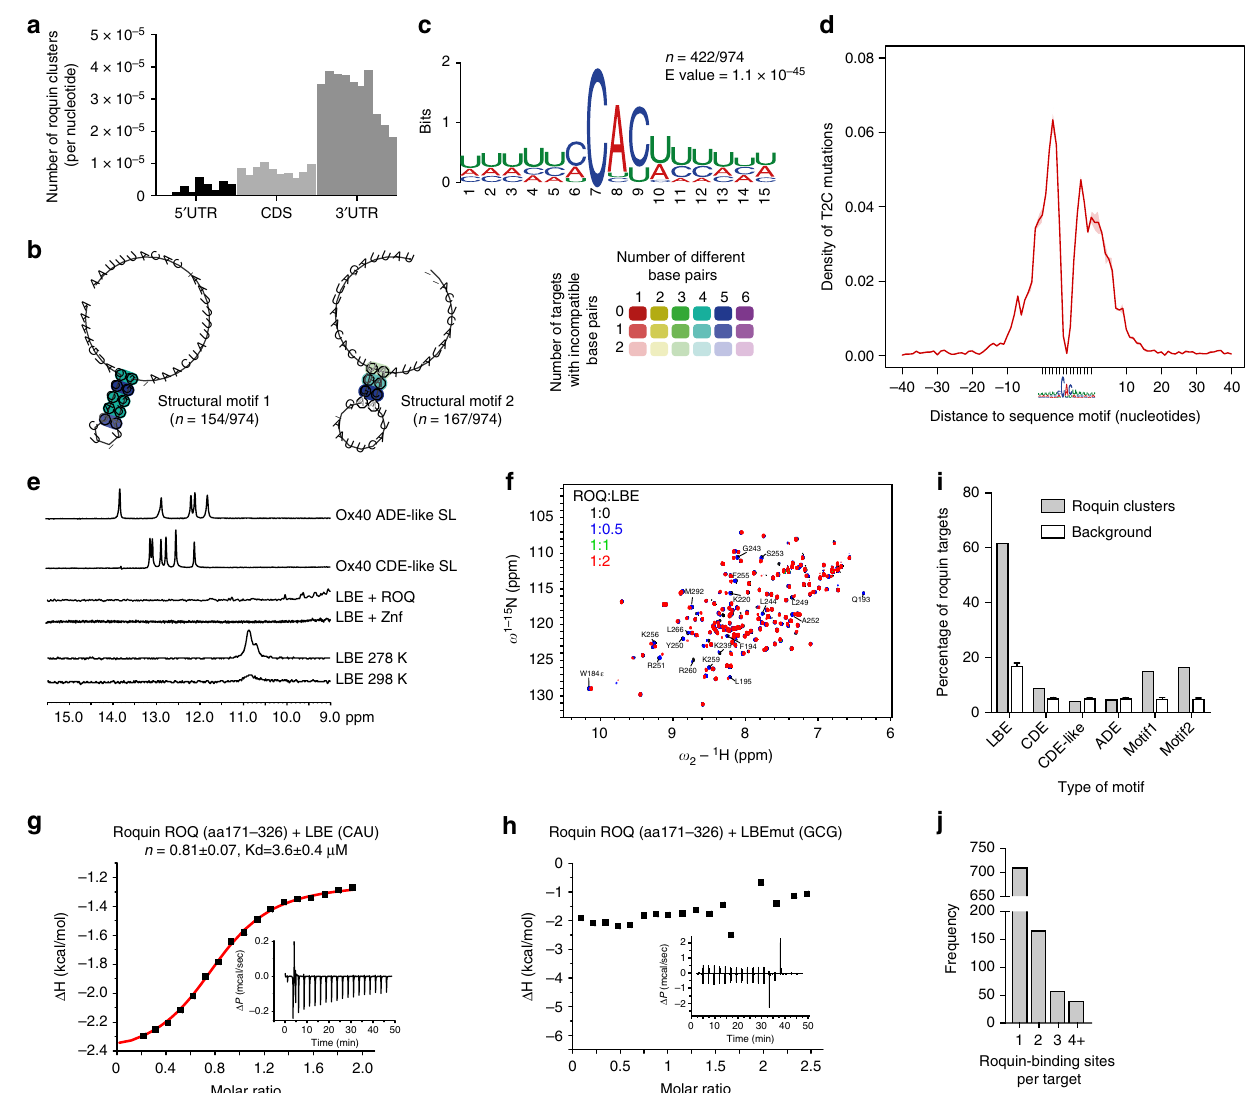
Fig. 1 Roquin PAR-CLIP identi fi es a linear binding element. a Number of Roquin-bound clusters per nucleotide identi fi ed within the 5 ′ - UTR, CDS and 3 ′ - UTR regions of the target mRNAs. Each bar represents a region covering one-tenth of the respective mRNA region. b Multiple sequence alignments along with the consensus sequence-structure RNA motif are shown for the two most over-represented motifs, both characterized by a stem – loop (SL) secondary structure with a U-rich loop, derived from the top 100 Roquin-bound clusters. The numbers within parentheses represent the fraction of Roquin-bound clusters with similar structural motif. The different colors provide information about the number of distinct base pairs occurring (up to six types: C:G, G:C, A:U, U:A, G:U, and U:G) whereas the shading indicates how many sequences/structures in the alignment do not form a particular base pair. c Consensus sequence generated by MEME/PhyloGibbs analysis of all the 974 Roquin-bound cluster sequences. d Density of T to C mutations in the regions surrounding the linear binding element (LBE) revealed an enrichment of mutations in the fl anking regions of the Py – Pu – Py core. Solid line and shadow represent the mean ± SEM. e Imino- 1 H- 1 D spectra of the Ox40 ADE-like and CDE-like SLs compared to the LBE (UUUUAA CAU UAUUUU) of the 3 ′ - UTR of Nfkbiz in the absence or presence of ROQ or zinc fi nger (Znf) domains of Roquin-1 and measured at RT or at temperatures as indicated. f Overlay of 1 H- 15 N HSQC spectra of the Roquin ROQ domain (aa171 – 326) either without (black) or with different stoichiometric amounts of the 15-mer LBE RNA from the Nfkbiz 3 ′ - UTR (in color). g ITC isotherm characterizing the binding of the ROQ domain of Roquin to the LBE RNA. The data were fi tted to a one-site binding model, K d and stoichiometry are indicated. h The same as in ( g ) but with a mutated form of LBE (UUUUAA GCG UAUUUU). i Percentage of Roquin clusters containing the different sequence and structural motifs as compared to those found in the same Roquin-binding sequences shuf fl ed (background model). j Frequency of mRNAs containing different number of Roquin-binding sites. Data are representative of three ( a – d , i , j ) and four ( g , h ) independent